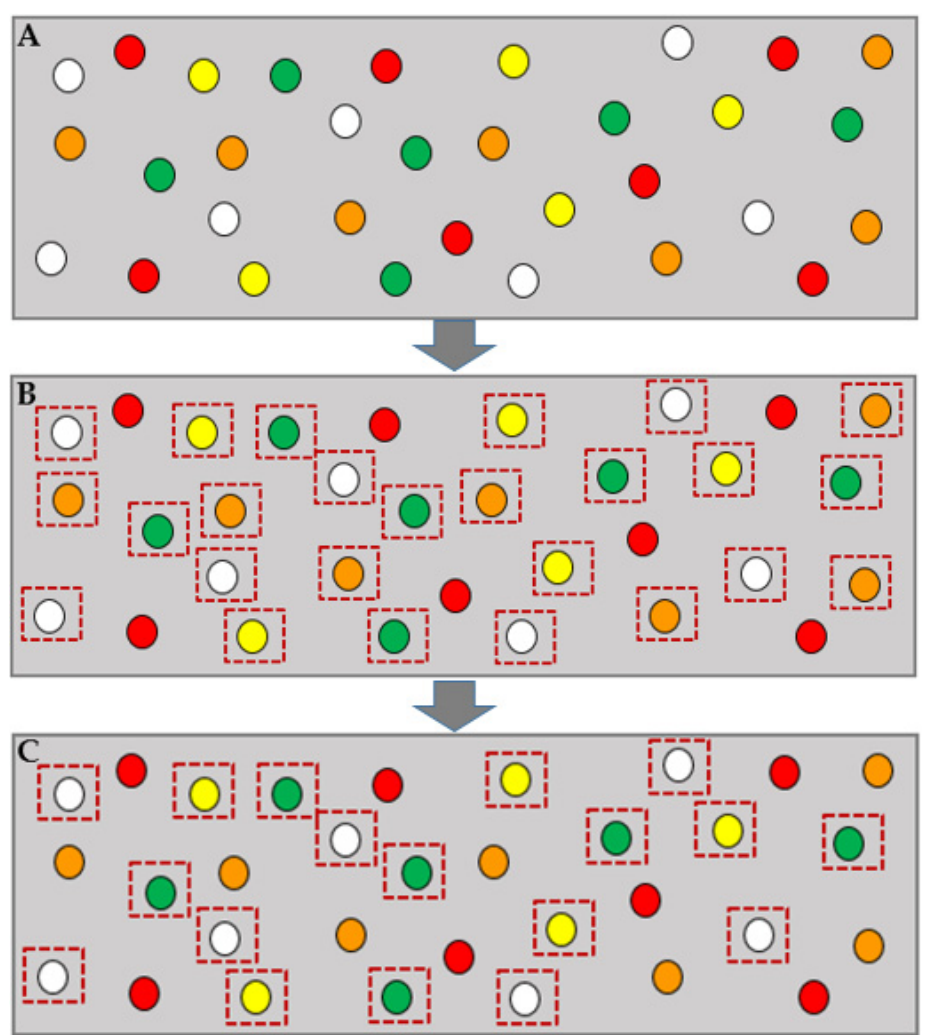
Figure 2. Feasible device set forming. ( A ) illustrates a learner fragment. Considering all IoT devices have enough bandwidth to help, feasible devices are specified in ( B ). Assuming the current emergency device’s priority is orange and Th = yellow (2), the feasible device set includes devices with priorities lower than yellow priority ( C ).